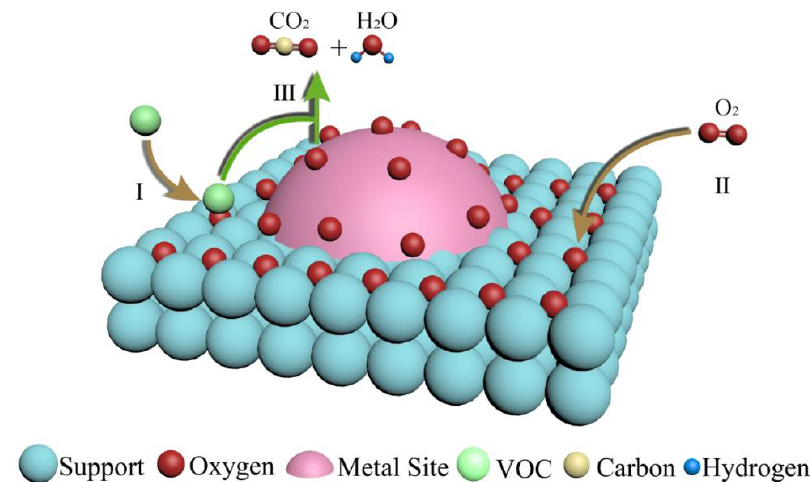
Figure 15. Langmuir–Hinshelwood mechanism illustrated. Reprinted with permission from Mu et al., Figure 15. Langmuir – Hinshelwood mechanism illustrated. Reprinted with permission from Mu et 2021 [31], Elsevier Ltd. al., 2021 [31], Elsevier Ltd.